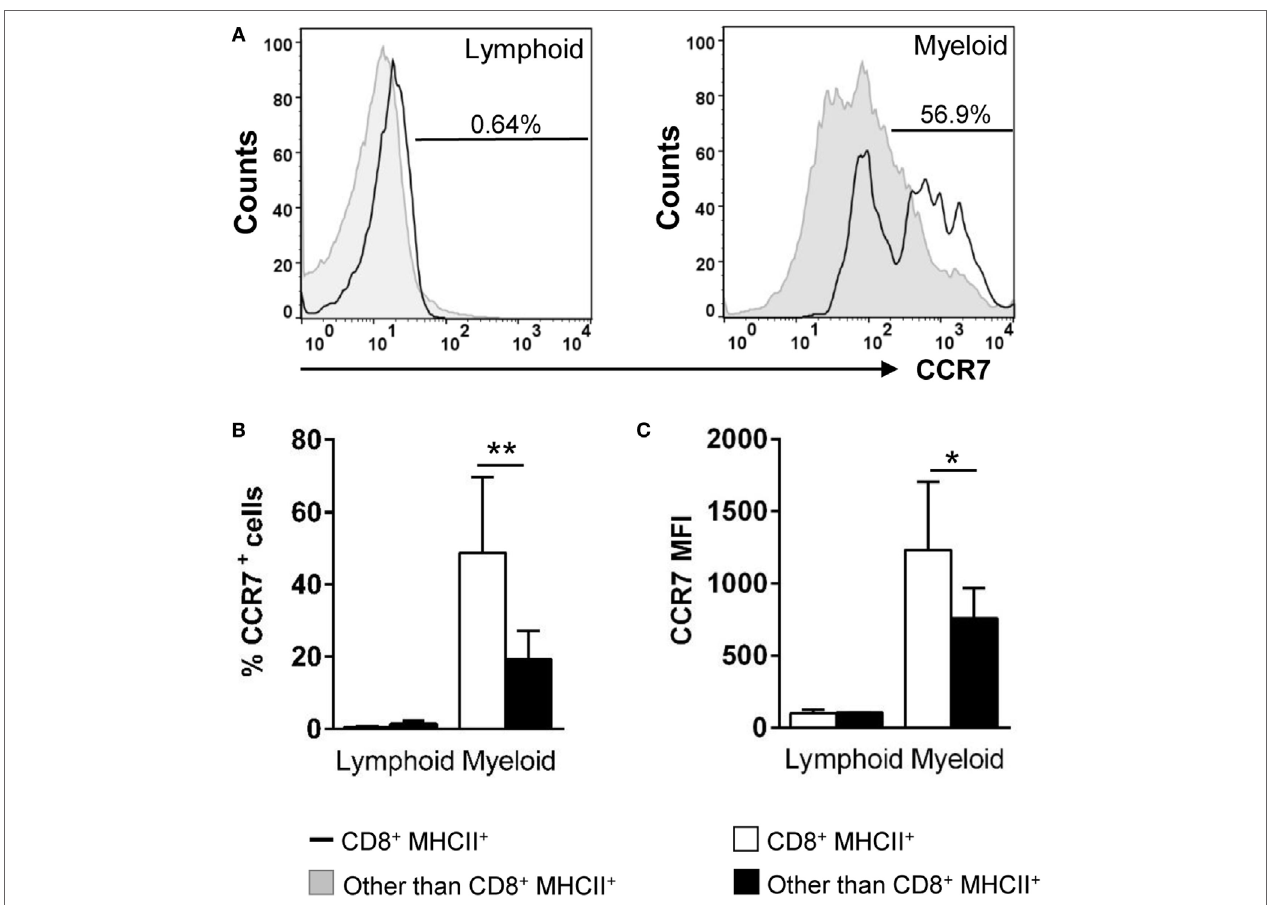
FigUre 4 | Expression of surface CCR7 on gill CD8 + dendritic cells (DCs). Trout leukocytes from gills were isolated, stained with specific Abs against CD8 α , major histocompatibility complex (MHC) II and CCR7, and analyzed by multicolor flow cytometry. (a) Cells were gated as lymphoid and myeloid on the basis of their FSC and SSC. Then, CD8 + MHC II + cells were further gated on those populations, and CCR7 fluorescence was determined in CD8 + DCs (open line histograms) and compared against the general CCR7 levels in each gate (filled line histograms). Numbers on plots correspond to the percentage of CCR7 + cells after exclusion of negative cells present on the isotype controls. Average percentage of CCR7 cells (B) and MFI of CCR7 expression (c) in gill lymphoid and myeloid populations were calculated. Data are representative of nine individual fish from three independent experiments (* p ≤ 0.05 and ** p ≤